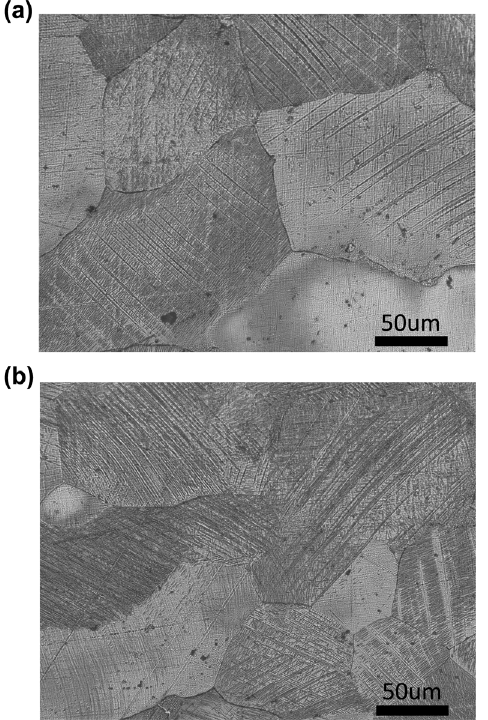
Figure 10: Twinning morphology of TWIP steel matrix before ( a ) and after ( b ) annealing heat